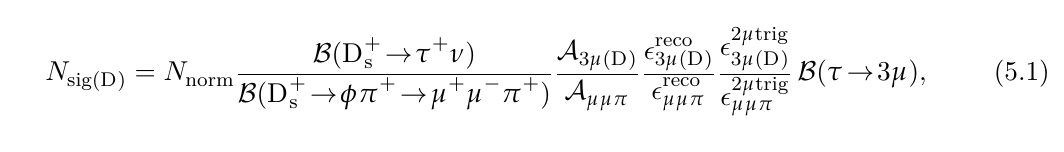
Figure 3 . Left: the mmp invariant mass distribution with fits to the D + and D + background. Right: background-subtracted proper decay length distribution for D + m + m − p + events (points) and the fitted contributions from D + s mesons produced directly (open histogram) and from b hadron decays (filled histogram). The highest bin also contains the overflow events. The vertical bars in both plots represent the statistical uncertainties in the